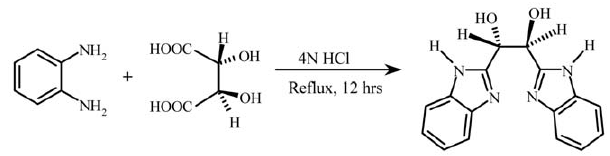
Figure 1. Preparation and structure of 1,2-Bis(2-Benzimidazo- lyl)-1,2-Ethanediol (BBE).